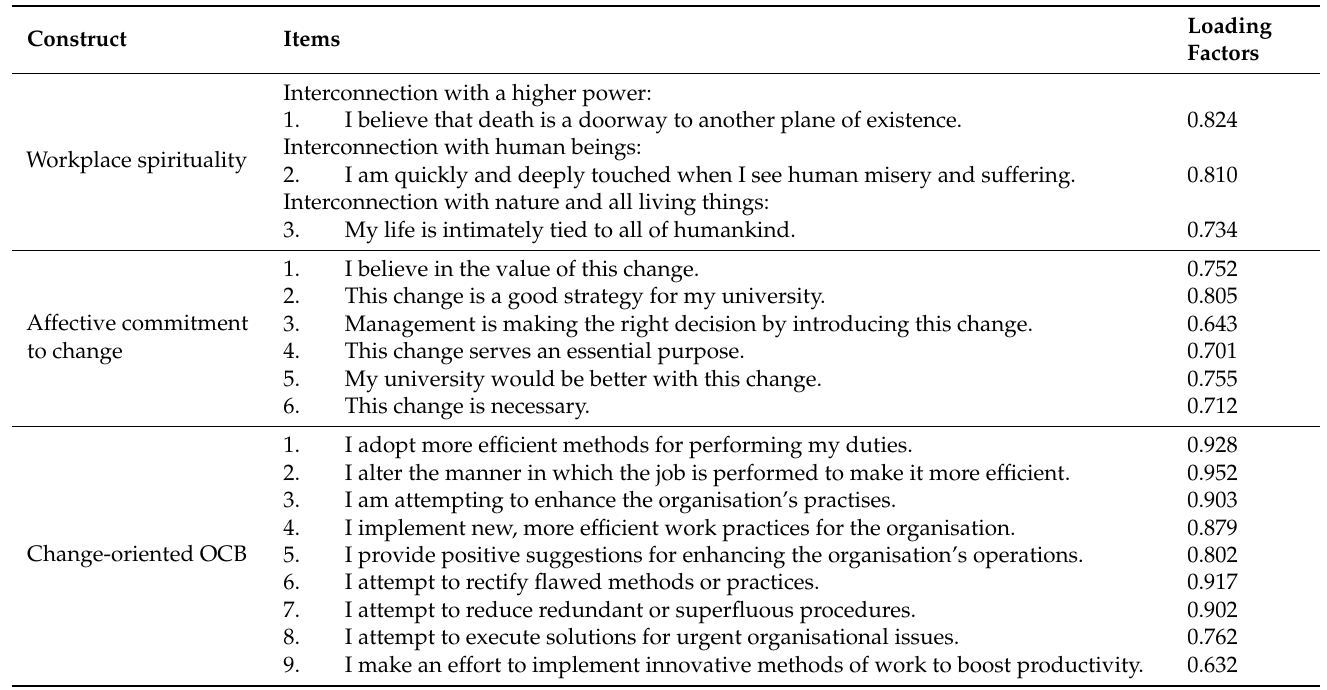
Table 2. Measurement model.